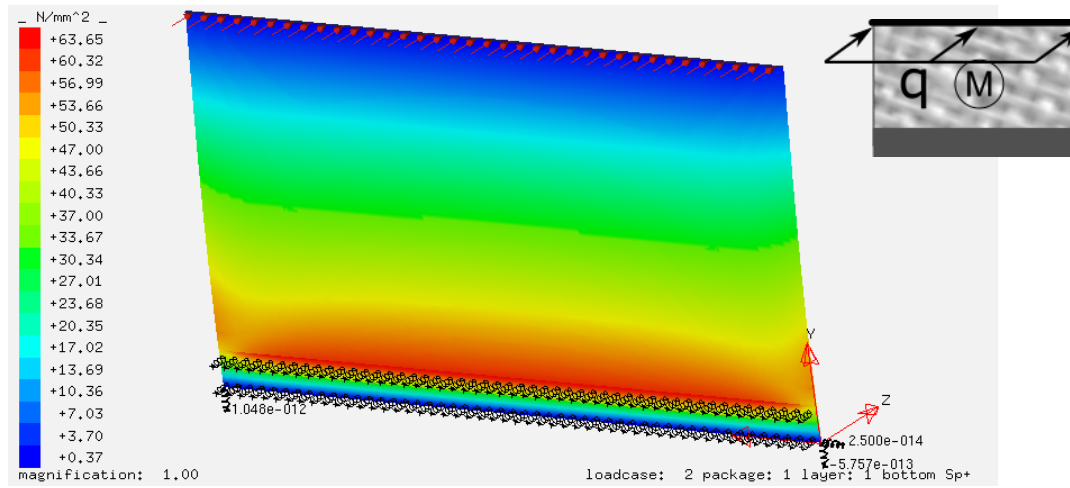
Fig. 5 Stress determination for the middle element M, situation "0_0" simulated with SJ